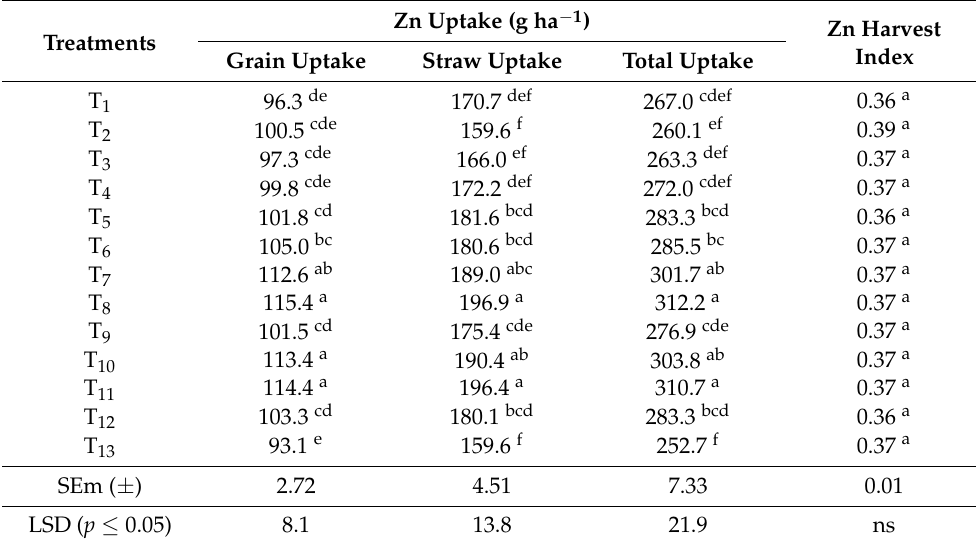
Table 6. Effect of different doses and frequencies of zinc application on wheat grain, straw, and total zinc uptake.